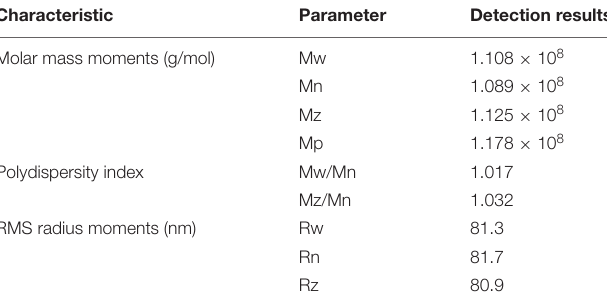
TABLE 1 | Relevant molecular parameters of the purified EPS-F2 in HPSEC-RI-MALLS analysis. Characteristic Parameter Detection results Molar mass moments (g/mol)